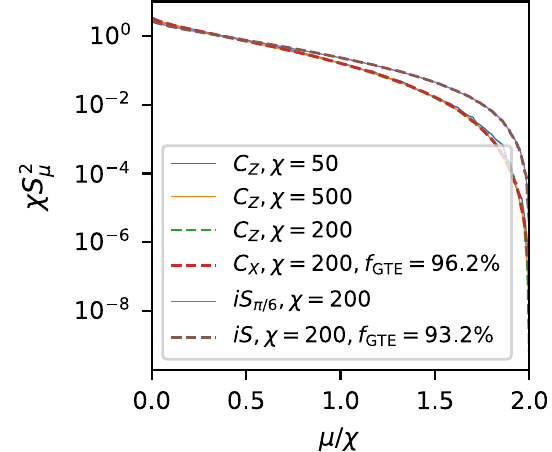
FIG. 9. Squared singular values S 2 μ of the matrix T 0 obtained from the GTE ensemble. We find a perfect scaling of the form S 2 μ ¼ g ð μ = χ Þ = χ , where μ is the index of the μ th singular value. The two bundles of curves correspond respectively to the C gates (two nonzero eigenvalues) and the iS π nonzero eigenvalues). Within one bundle, the different curves are